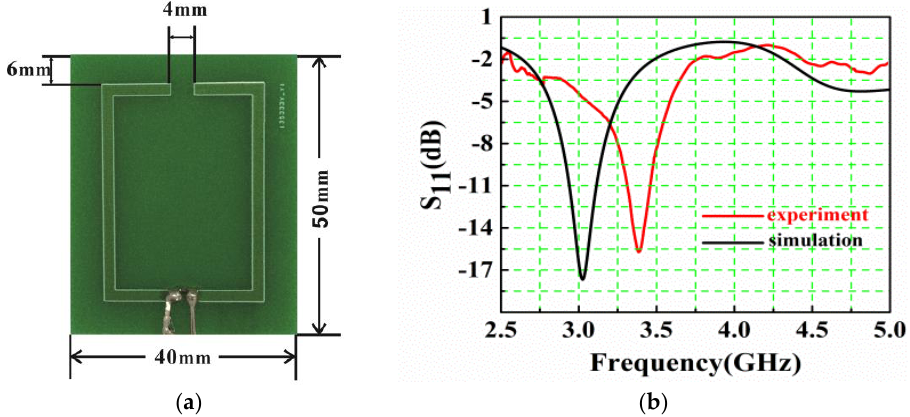
Figure 2. The split-ring based sensor. ( a ) Prototype board; ( b ) Experimental ( red ) and simulated ( black , without Schottky diode) frequency response curves.